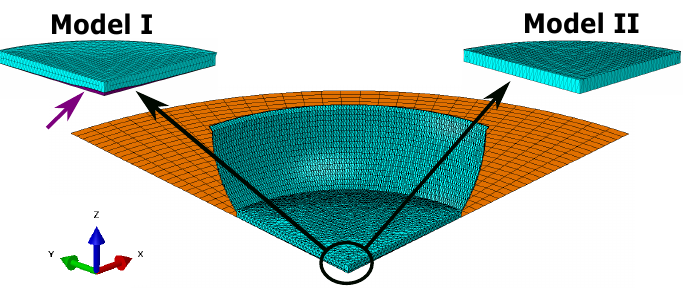
Figure 3. Vitroceramic glass is represented in orange, and the multilayer round WMF pan is repre- sented in blue. Model I is modelled with the air (purple instance) between the glass and the pan, while Model II replaces the air by modelling the interaction between the vessel and glass by a variable thermal conductance coefficient along the